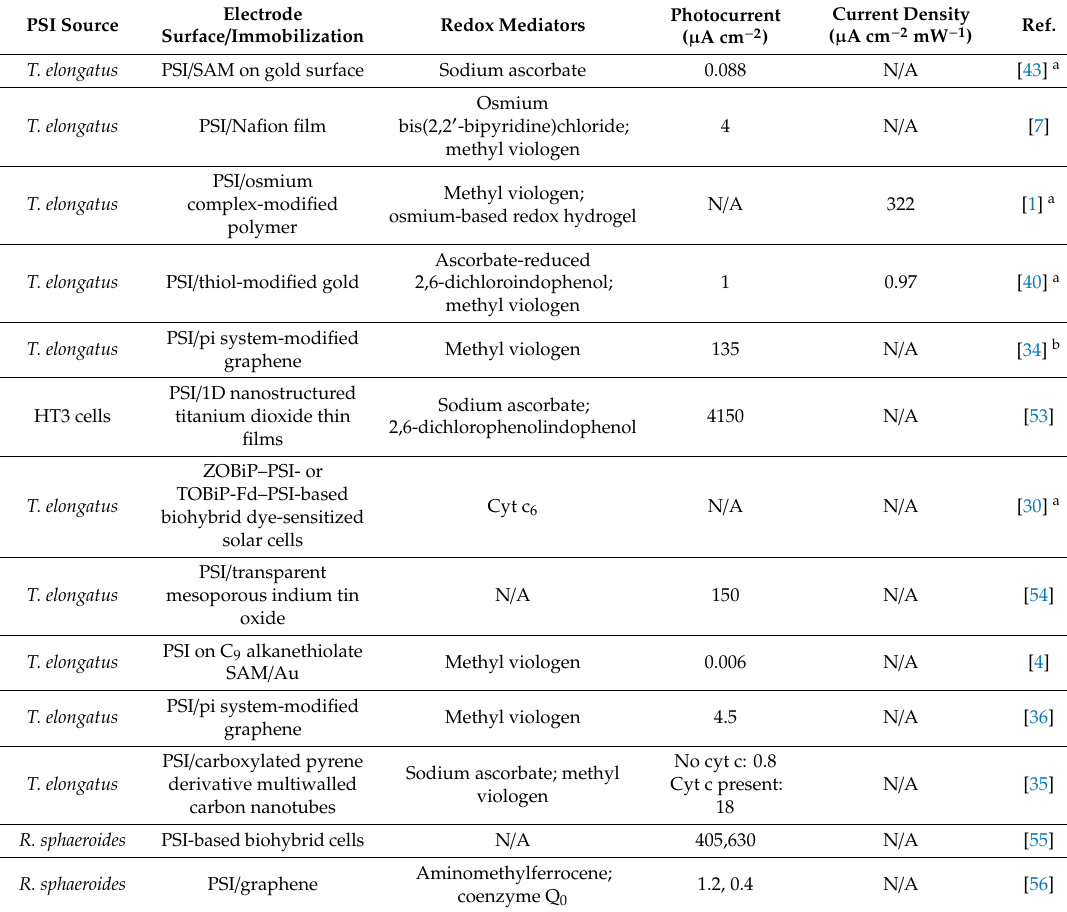
Table 2. Photocurrent Analysis of Cyanobacterial PSI-Based Biohybrid Devices ‡